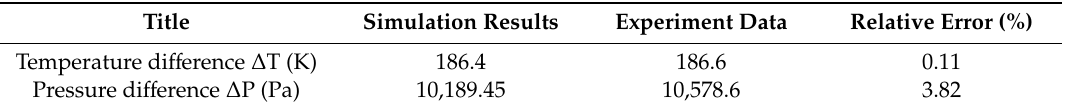
Table 2. Comparison between simulation and experimental results at 10 MPa: relative error.